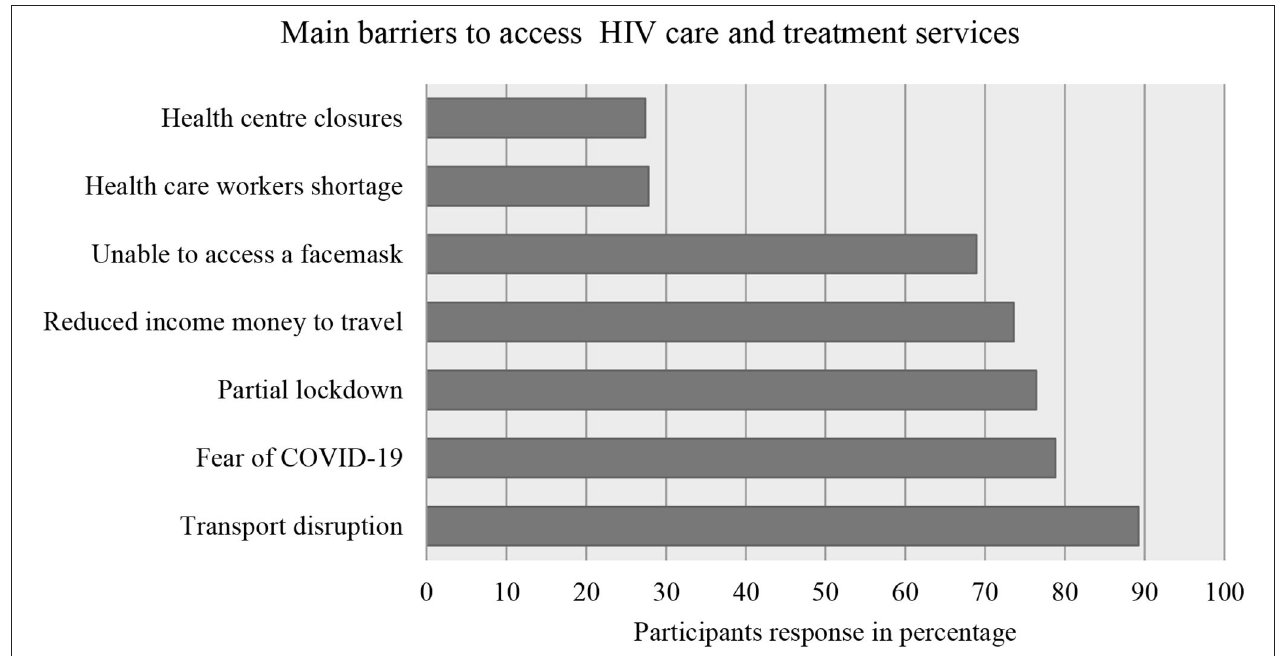
FIGURE 1 | Response of the study participants regarding barriers in accessing health care and treatment during the pandemic, Addis Ababa, Ethiopia, May 2021.